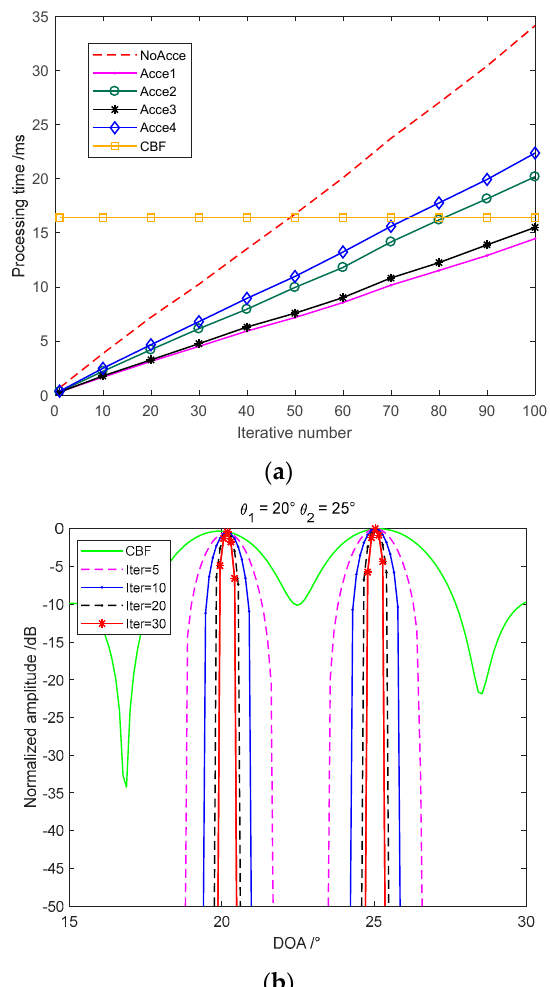
Figure 4. Processing time of different algorithms and the beamwidth with the increasing iterative number: ( a ) processing time of different algorithms; and ( b ) imaging beamwidth with the increasing iterative number.